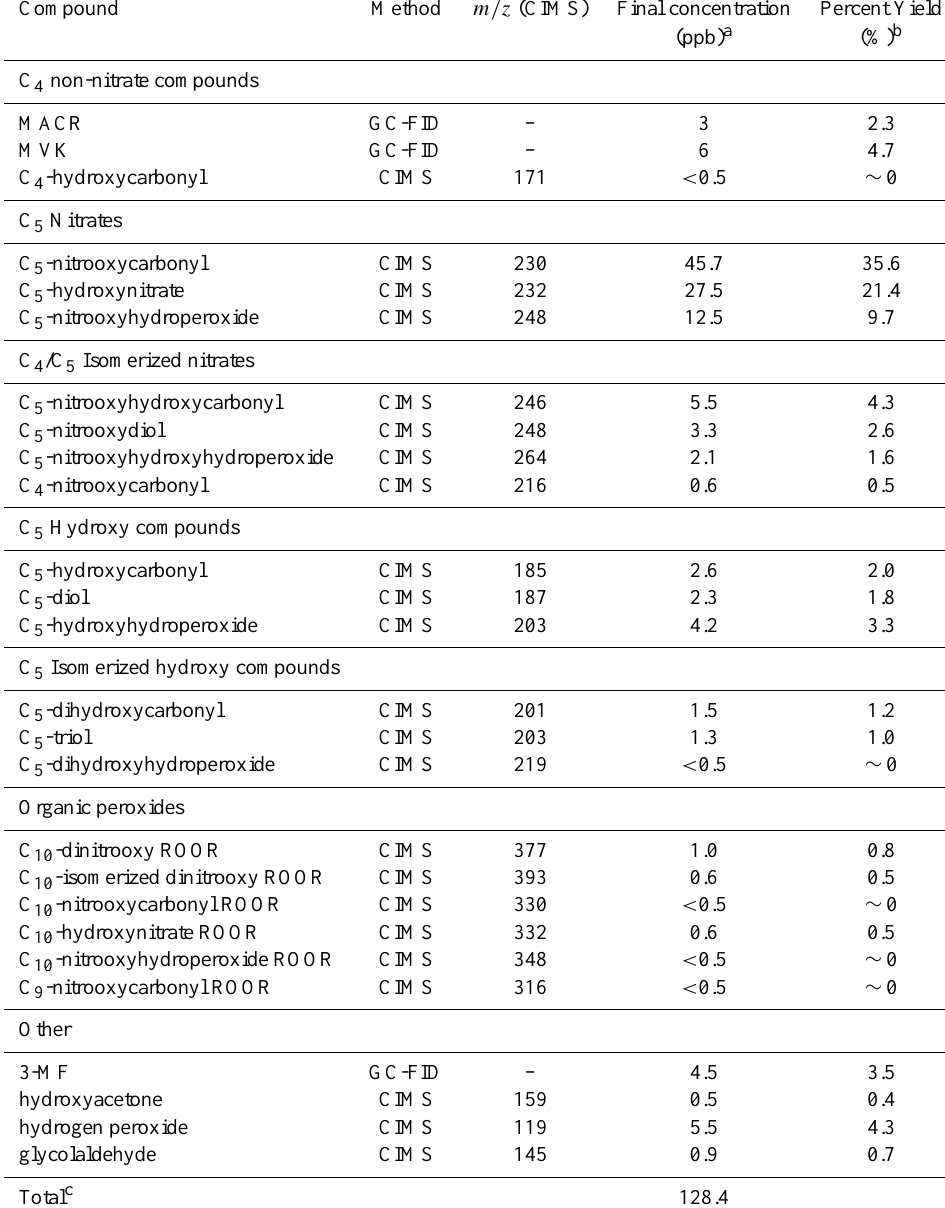
Table 1. Products detected by GC-FID and CIMS.